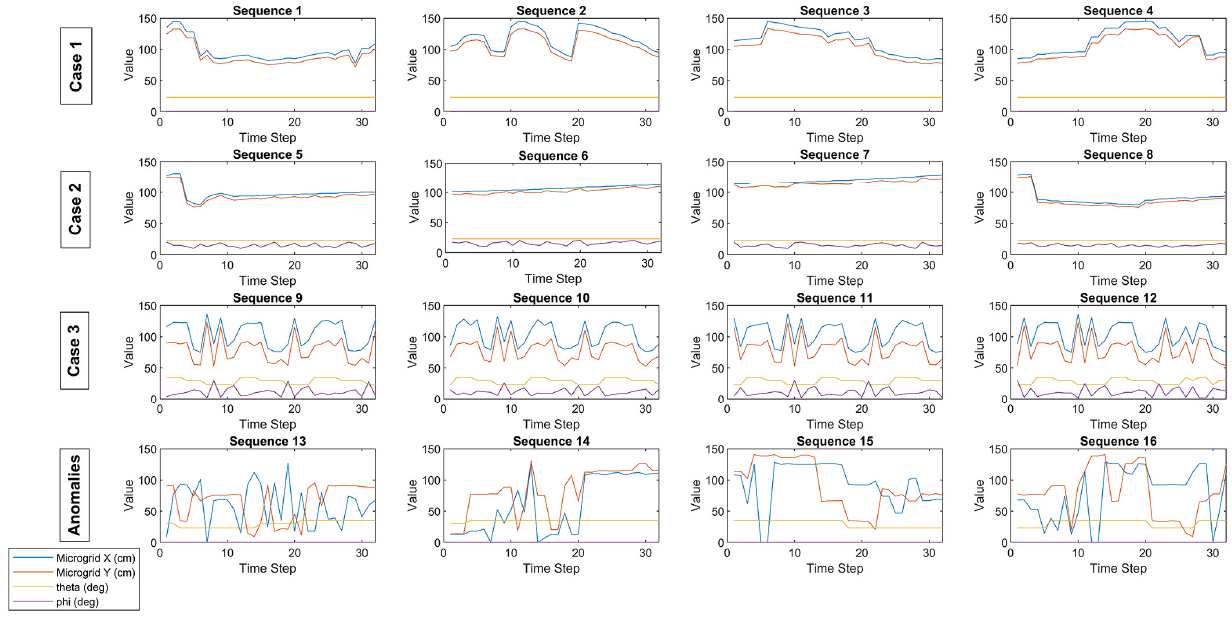
Figure 6. Initial Classification of the Movement Behavior of Users.